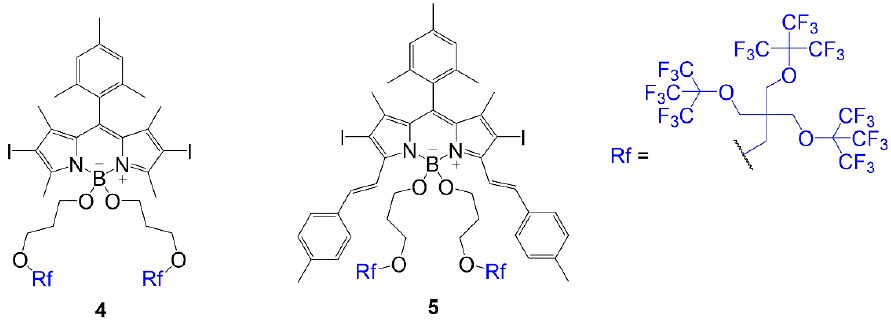
Figure 3. BODIPY with multi-branched fluorinated chains attached to boron center [21].